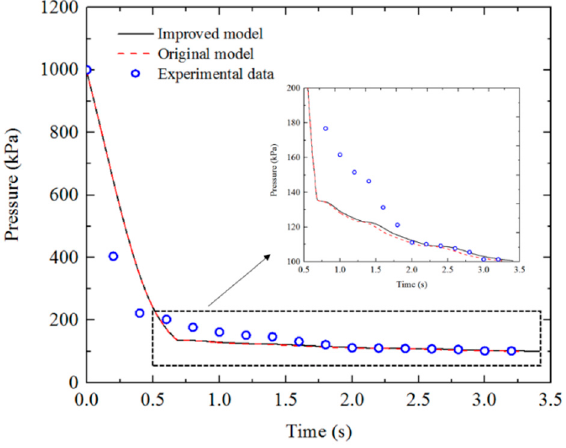
Figure 5. Comparison between experimental and simulated pressures in the tank. The experimental data were taken from Botterill et al. [39]. data were taken from Botterill et al.